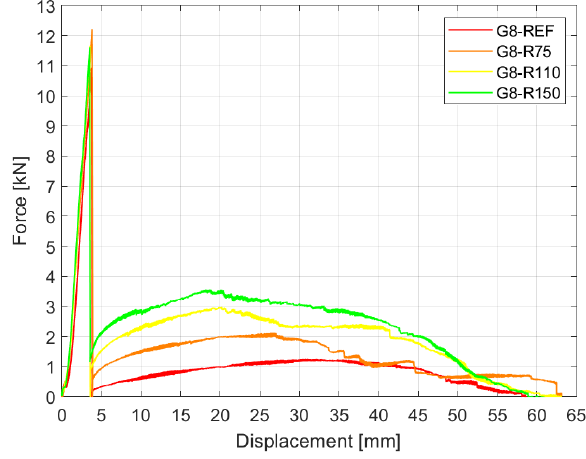
Figure 5. Results of experiments: force–displacement history for test series G8.